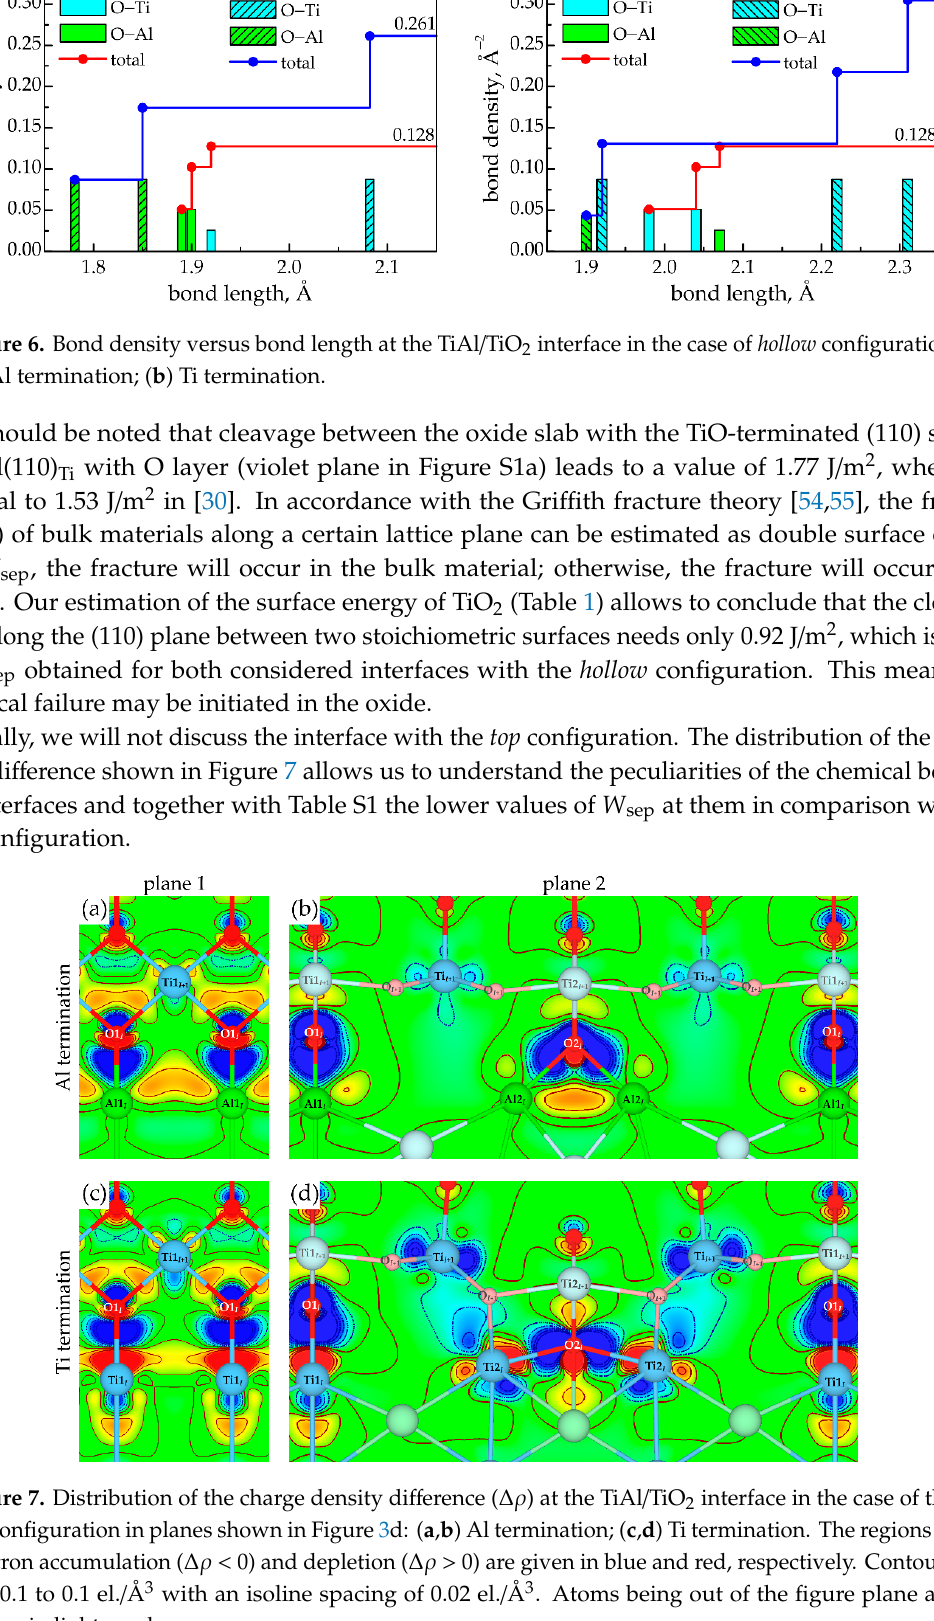
Figure 6. Bond density versus bond length at the TiAl/TiO 2 interface in the case of hollow configuration: ( a ) Al termination; ( b ) Ti termination.